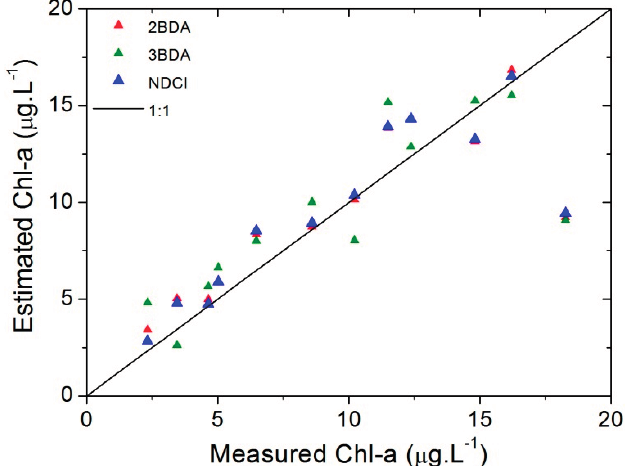
Figure 7. Scatterplots of the Measured vs. Estimated chl- a for each model using in situ hyperspectral data with chl- a values below 20 µg·L − 1 .